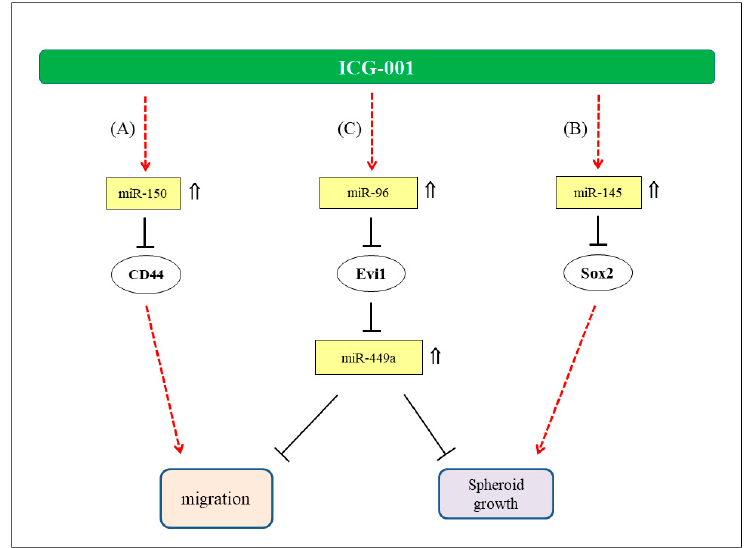
Figure 8. Hypothetical mode of anti-tumor action of ICG-001 in NPC. ( A ) Involvement of miR-150 / CD44 axis in the migration of NPC cells (23). ( B ) Regulation of NPC tumor spheres growth via miR-145 / SOX2 axis (22). ( C ) Regulation of NPC cell migration and growth of tumor spheres via miR-96 / Evi1 / miR-449s axis. ⇑ : Upregulated expression in ICG-001-treated NPC cells.